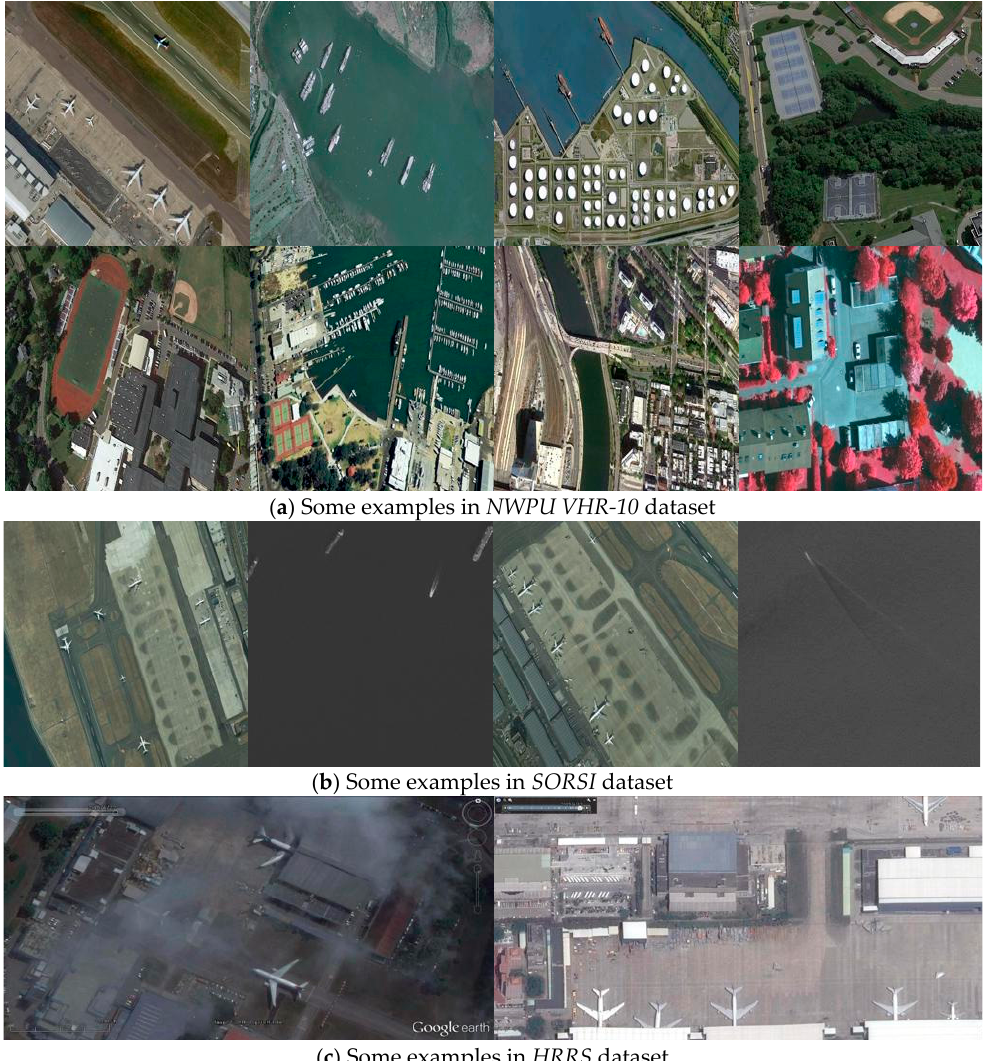
Figure 4. Example images of NWPU VHR-10/SORSI/HRRS datasets.